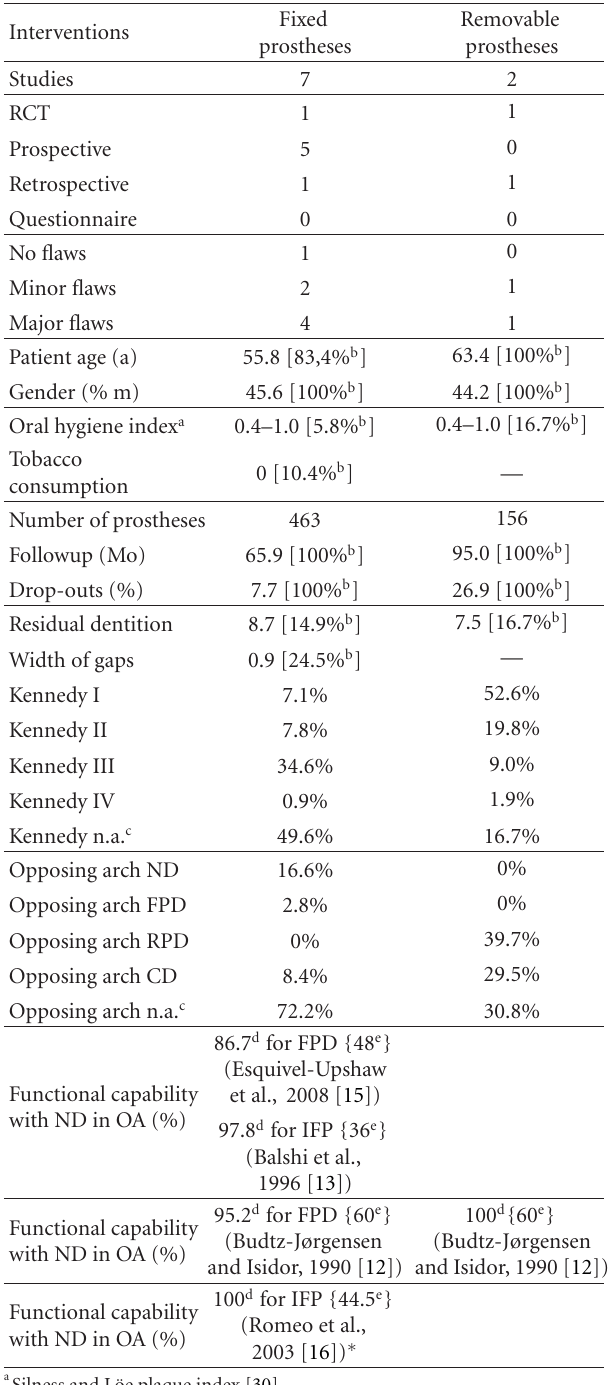
Table 6: Results on the longevity of fixed and removable